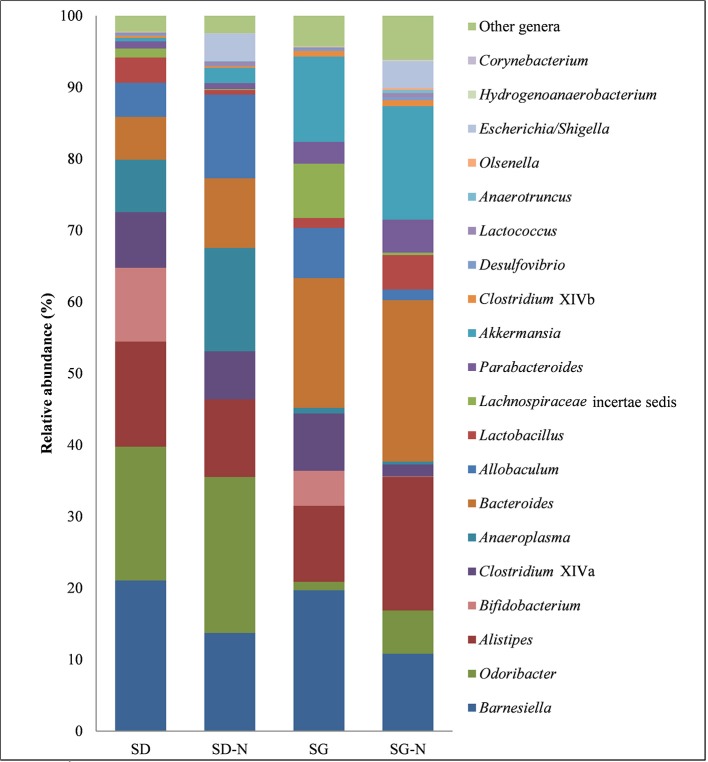
Relative abundance at genus level with respect to each diet. Diet group are as follows: starch dough (SD), starch dough containing nisin (SD-N), starch gel (SG), and starch gel containing nisin (SG-N) diet (n = 10).